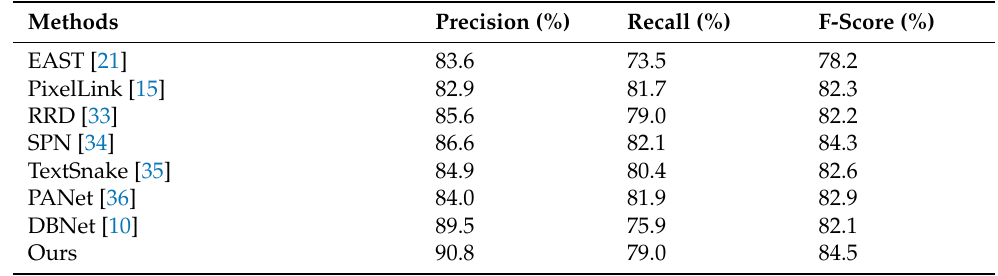
Table 5. Performance comparison of the model proposed in this paper with other models on the ICDAR2015 dataset.